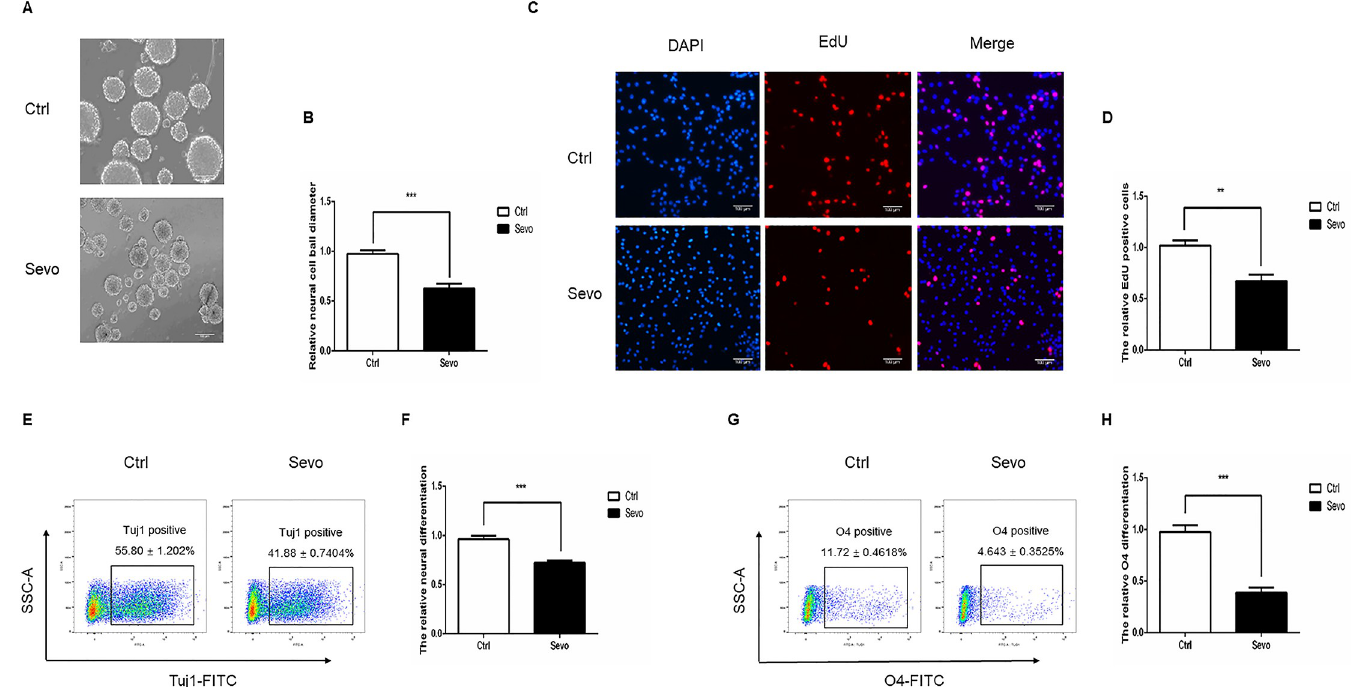
Fig 3. Multiple sevoflurane exposures inhibit the neurosphere formation, proliferation, and differentiation of NSCs. A, B. The neurosphere formation assay indicated that sevoflurane exposure decreased the self-renewal of NSCs. C, D. The EdU assay displayed that sevoflurane exposure reduced the proliferation of NSCs. E, F. Flow cytometry analysis revealed that multiple sevoflurane exposures decreased neuronal differentiation of NSCs. G, H. Multiple sevoflurane exposures inhibited the oligodendrocyte differentiation of NSCs. Data are representative images, charts or expressed as the mean ± SEM of each group of cells from three separate experiments. � P < 0.05, �� P < 0.01, ��� P < 0.001, determined by Student T test.